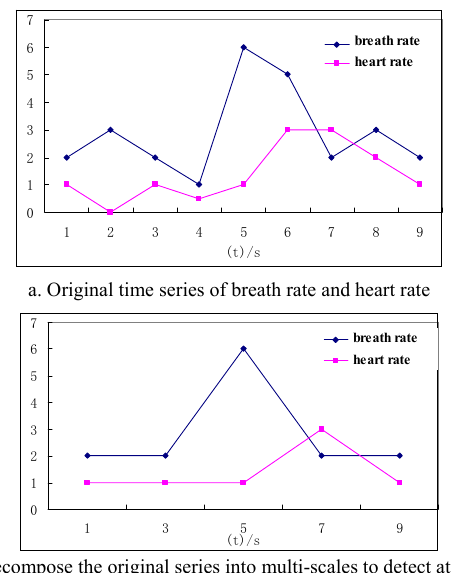
Fig. 1. Multi-scale phenomenon